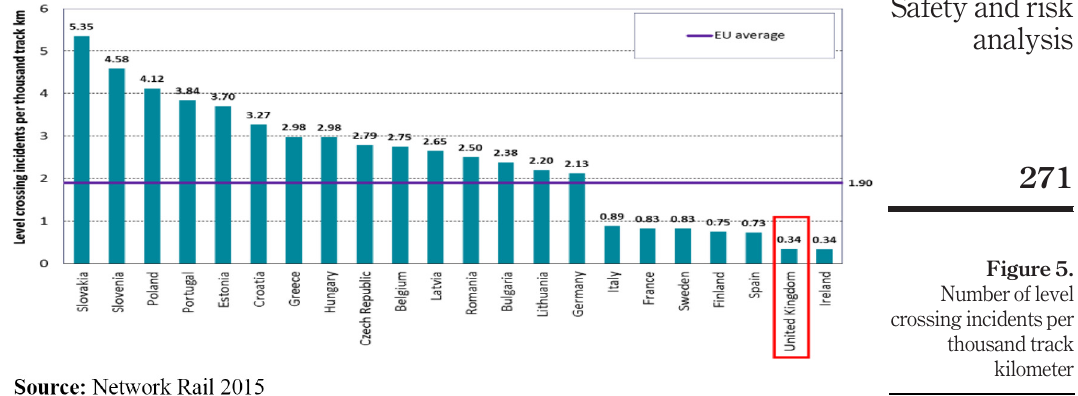
Figure 5. Number of level crossing incidents per thousand track